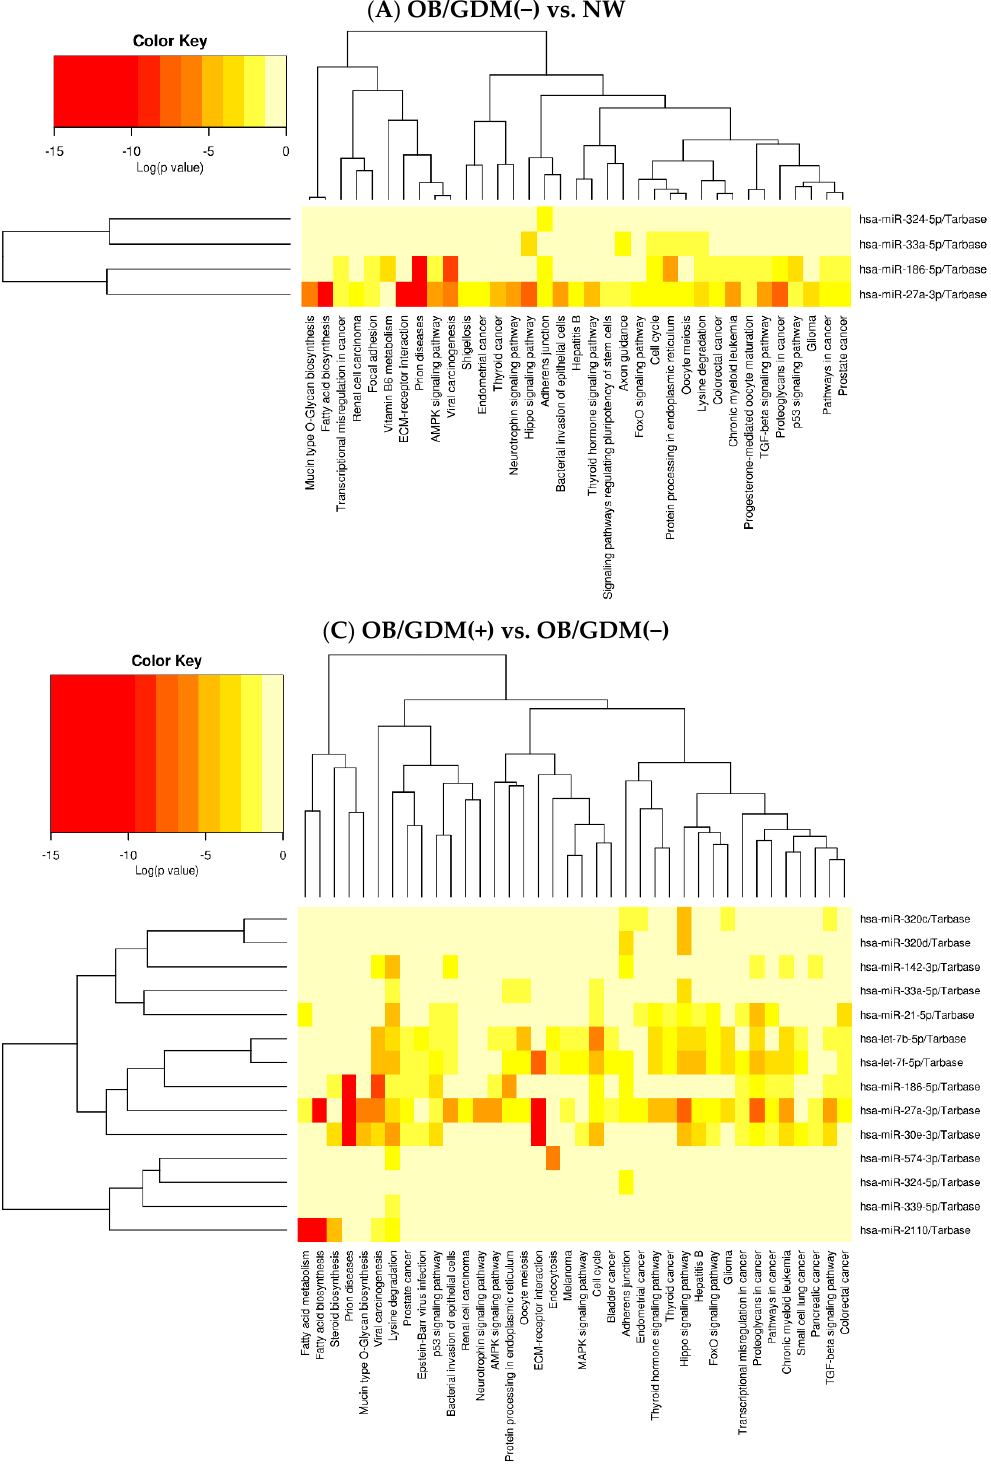
Figure 2. Heat maps by DIANA–miRPath v.3 showing miRNAs’ clusters and associated pathways obtained by union analysis for the following comparisons: (A) OB/GDM( − ) vs. NW, and (C) OB/GDM(+) vs. OB/GDM( − ). For each panel, the analysed miRNAs are listed on the right. The specific pathways, determined to be significant via miRNA pathway enrichment analysis, are listed at the bottom. The force of association (Log( p -value)) between the analysed miRNAs and the pathways is indicated by the colour key reported in the upper left corner. Log: log10 p